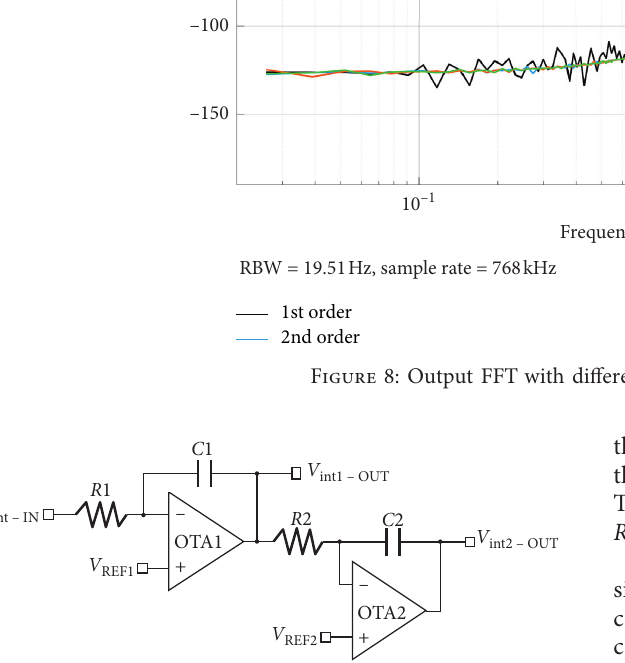
Figure 9: Circuit diagram of the second-order integrator.